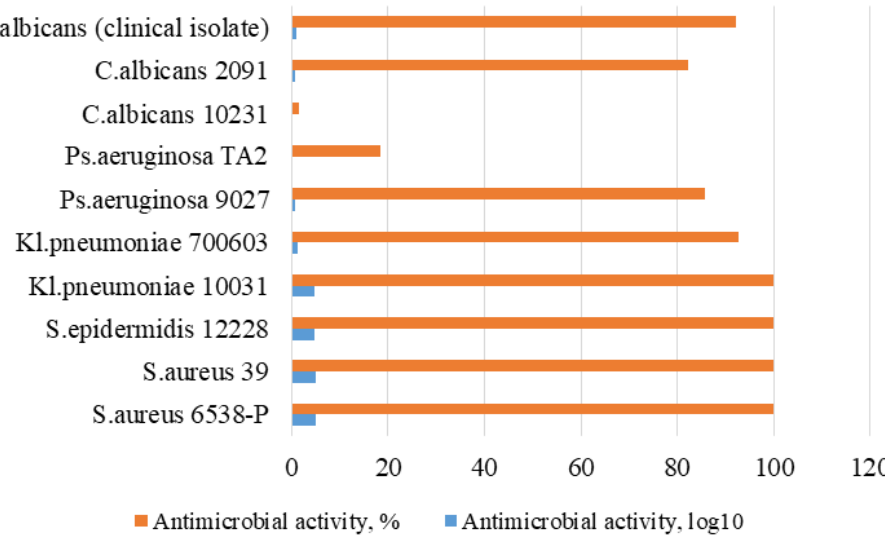
Figure 8. The change in the antimicrobial activity against different strains of microorganisms of the polymer composite with 5 wt.%-triclosan.